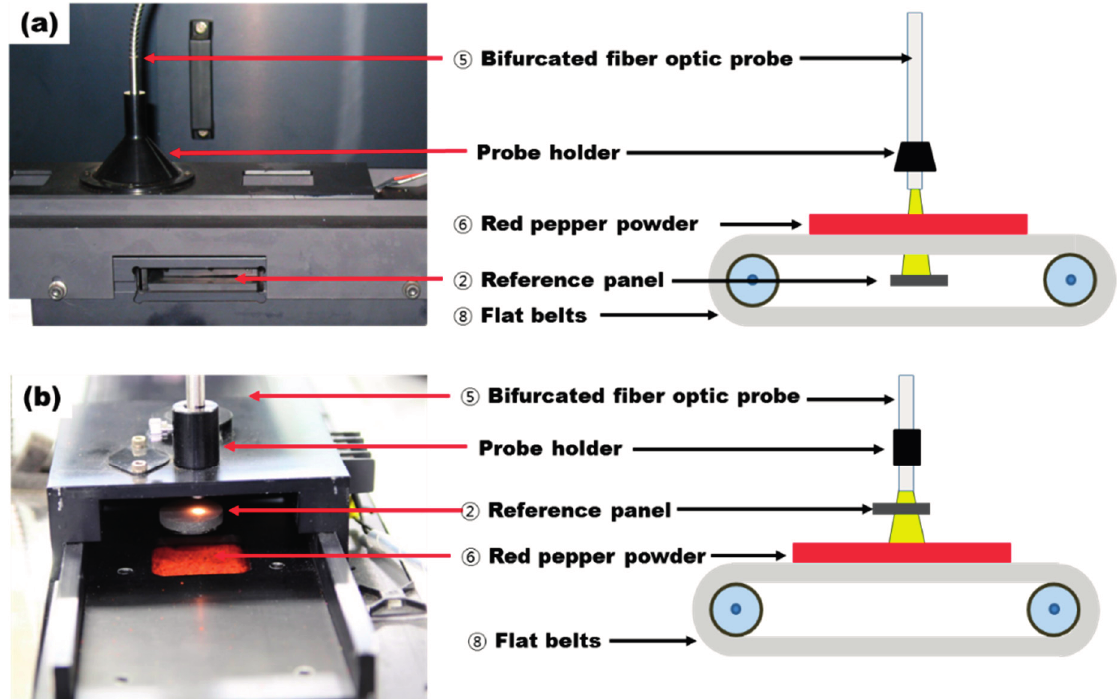
Figure 7. Photos comparing the standard reference in the automated reference-measuring unit to prevent the red pepper powder from contaminating mounting the reference in the lower part in the initial device ( a ) and mounting the reference in the upper part in the improved device ( b